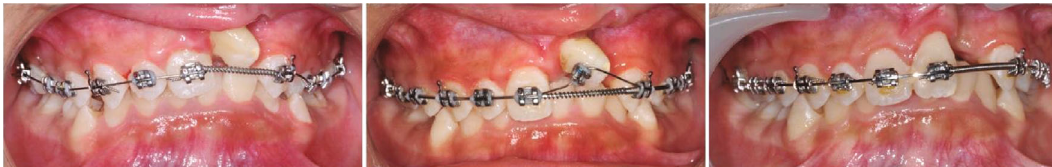
Figure 6: Tooth 21 recovery in the dental arch.